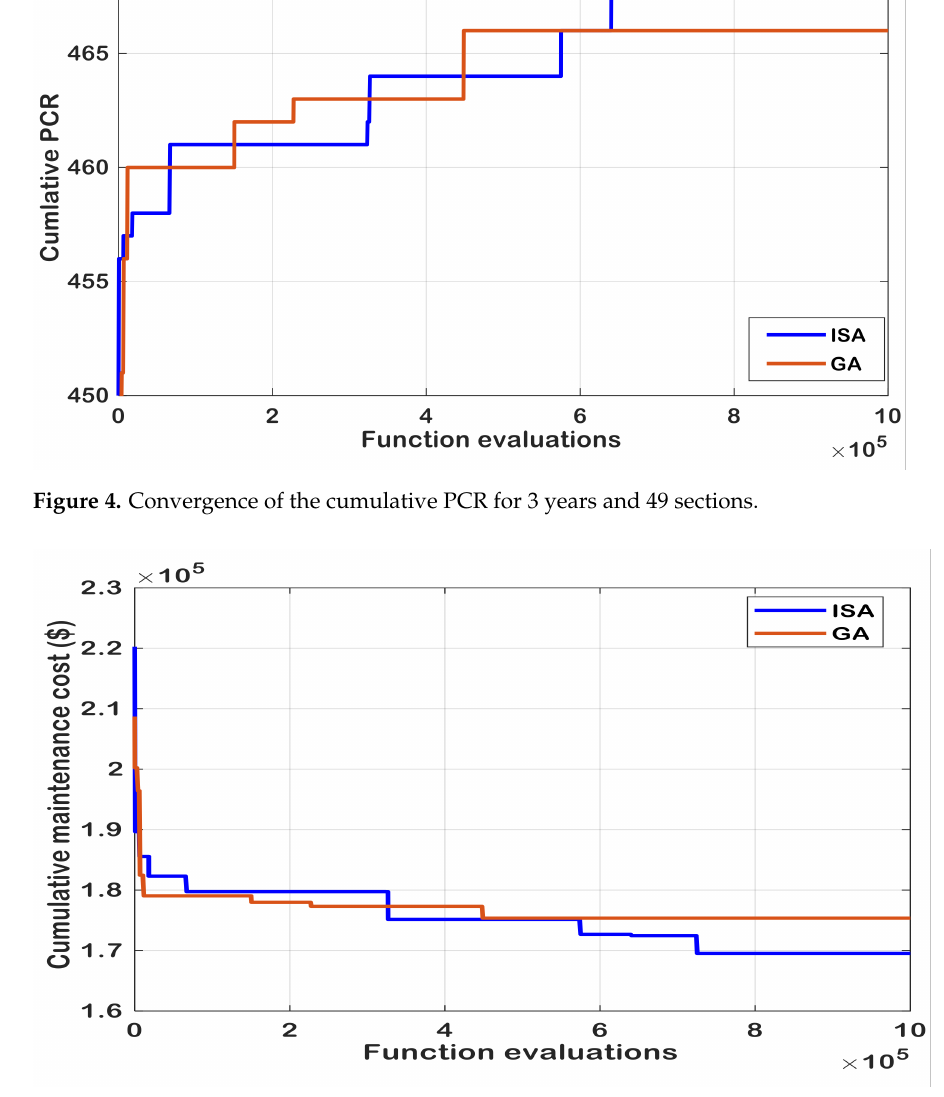
Figure 5. Convergence of the cumulative maintenance cost for 3 years and 49